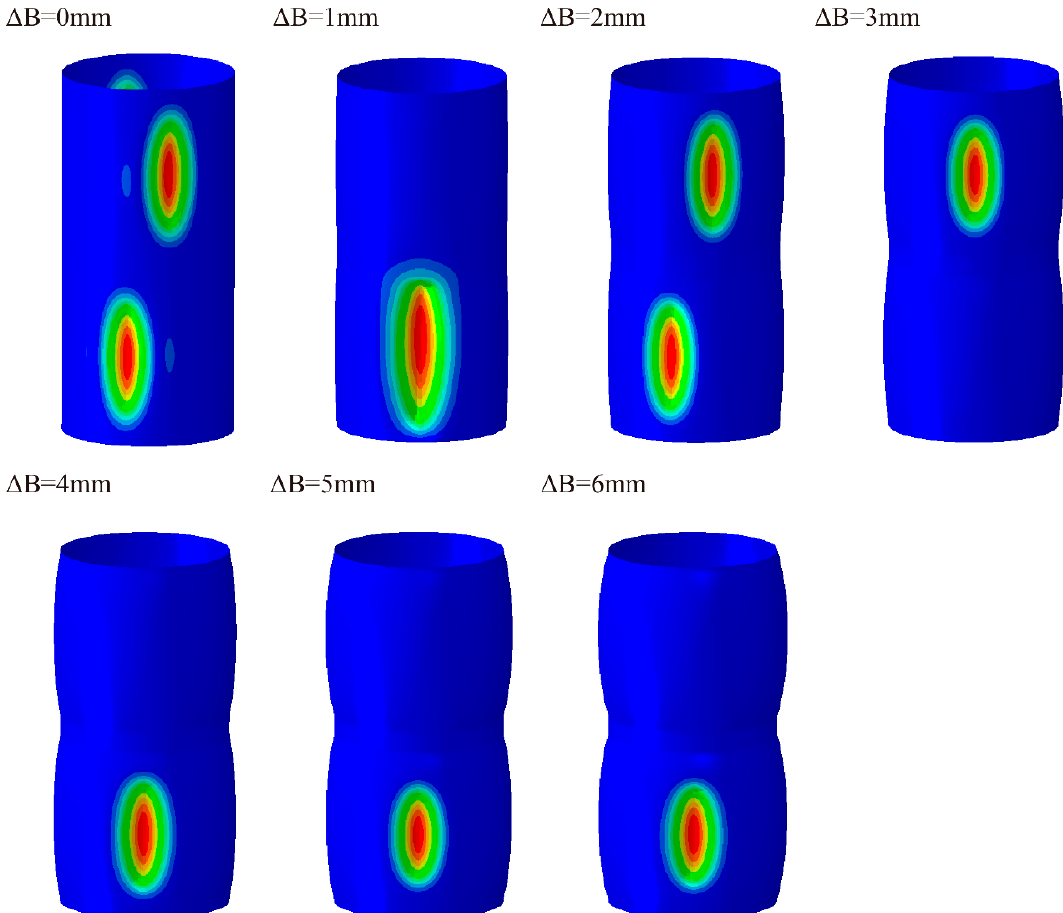
Figure 22. Nonlinear post-buckling modes of bi-segment bulged hulls obtained from numerical analysis at an imperfection size of 0.2𝑇 .